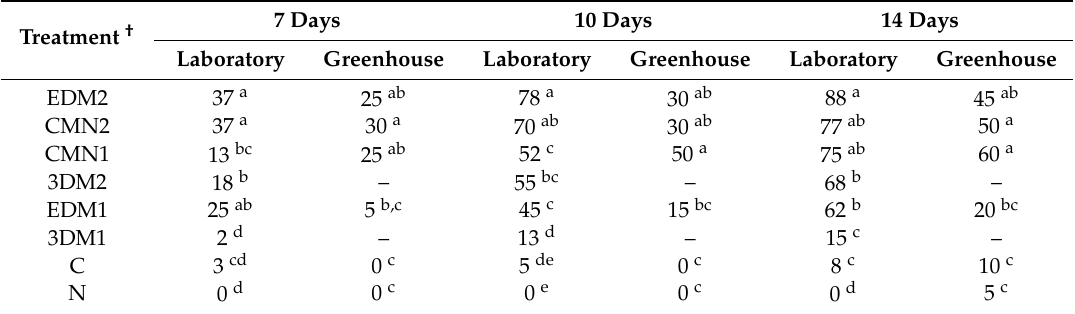
† 3DM1 = 3 days’ exposure (STE) to M. brunneum at low concentration (0.15 × 10 9 conidia g − 1 ). 3DM2 = 3 days’ exposure (STE) to M. brunneum at high concentration (0.49 × 10 9 conidia g − 1 ). EDM1 = Continuous exposure (LTE) to M. brunneum at low concentration (0.15 × 10 9 conidia g − 1 ). EDM2 = Continuous exposure (LTE) to M. brunneum at high concentration (0.49 × 10 9 conidia g − 1 ). CMN1 = 3 days’ exposure (STE) to M. brunneum and P. locustae at